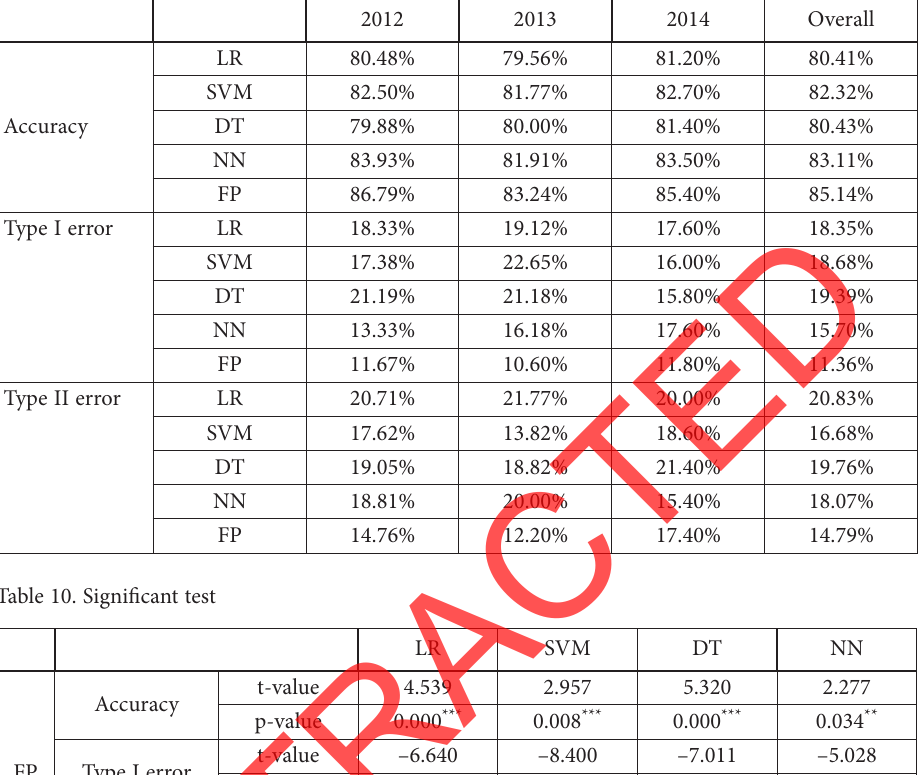
Table 9. Accuracy, Type I error and Type II error of the prediction results